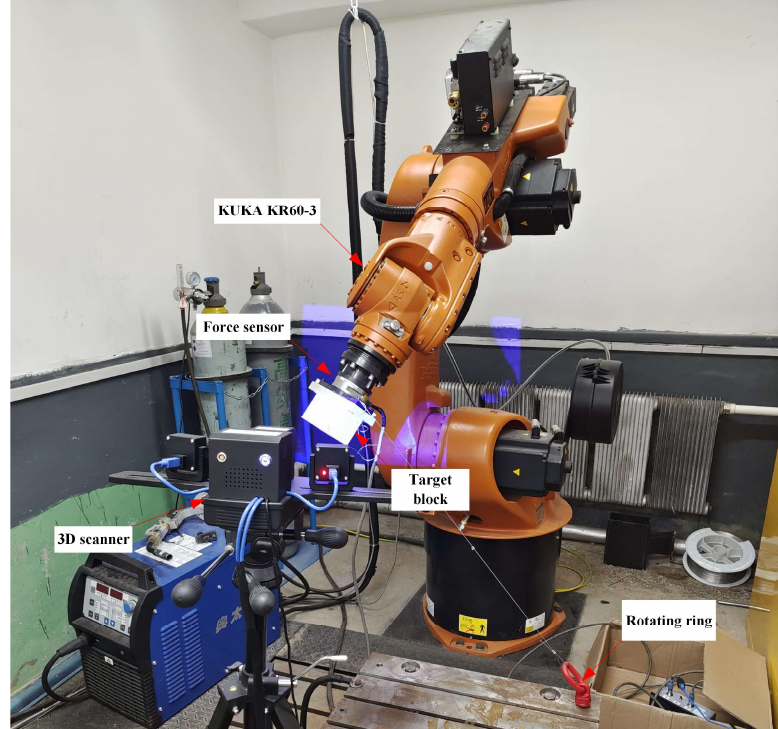
Figure 9. Experimental setup. Table 4. ATI force sensor